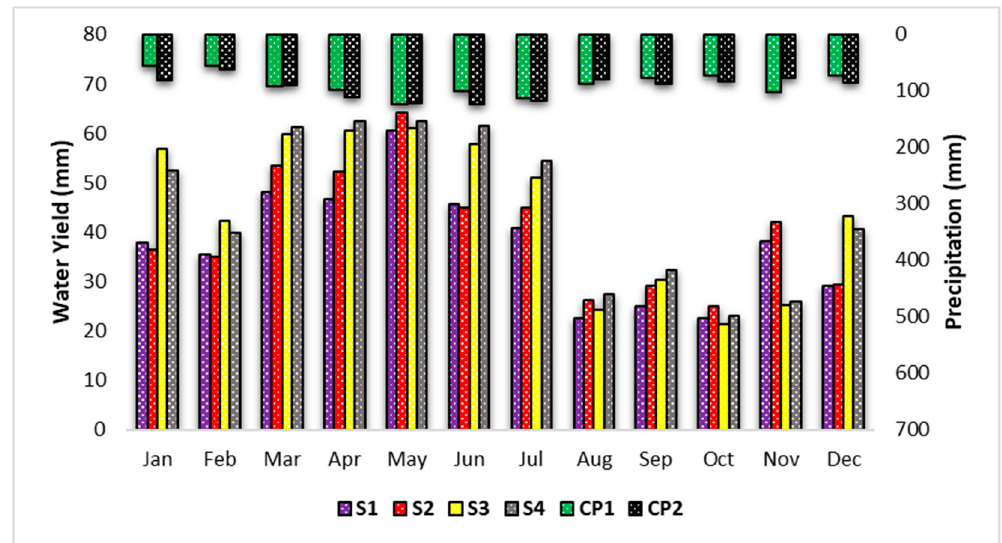
Figure 8. Average monthly water yield for the LEC watershed under different scenarios.